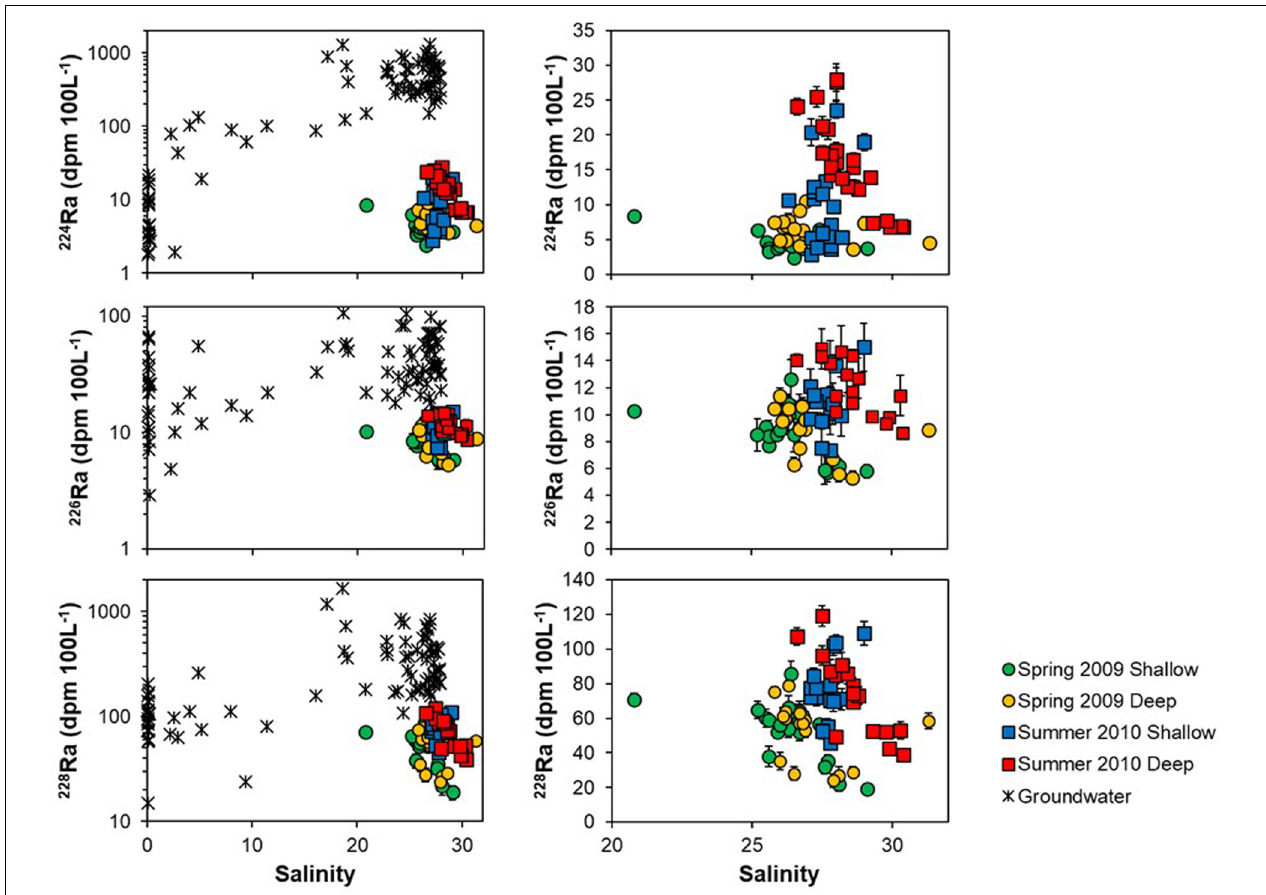
FIGURE 2 | Dissolved Ra vs salinity for Long Island Sound surface waters, bottom waters, and groundwaters. Surface and bottom water samples are presented in the right-hand panels for improved visualization and are arranged by season, from Garcia-Orellana et al. (2014). Groundwater samples are from intertidal cluster wells and shoreline piezometer stations on Long Island (Tamborski et al., 2017a) and Connecticut (Garcia-Orellana et al., 2014). TABLE 3 | Summary of groundwater Ra endmembers from Long Island (LI) and Connecticut (CT) shorelines. Groundwater source Salinity 224 Ra 226 Ra 228 Ra 228 Ra/ 226 Ra dpm 100 L −